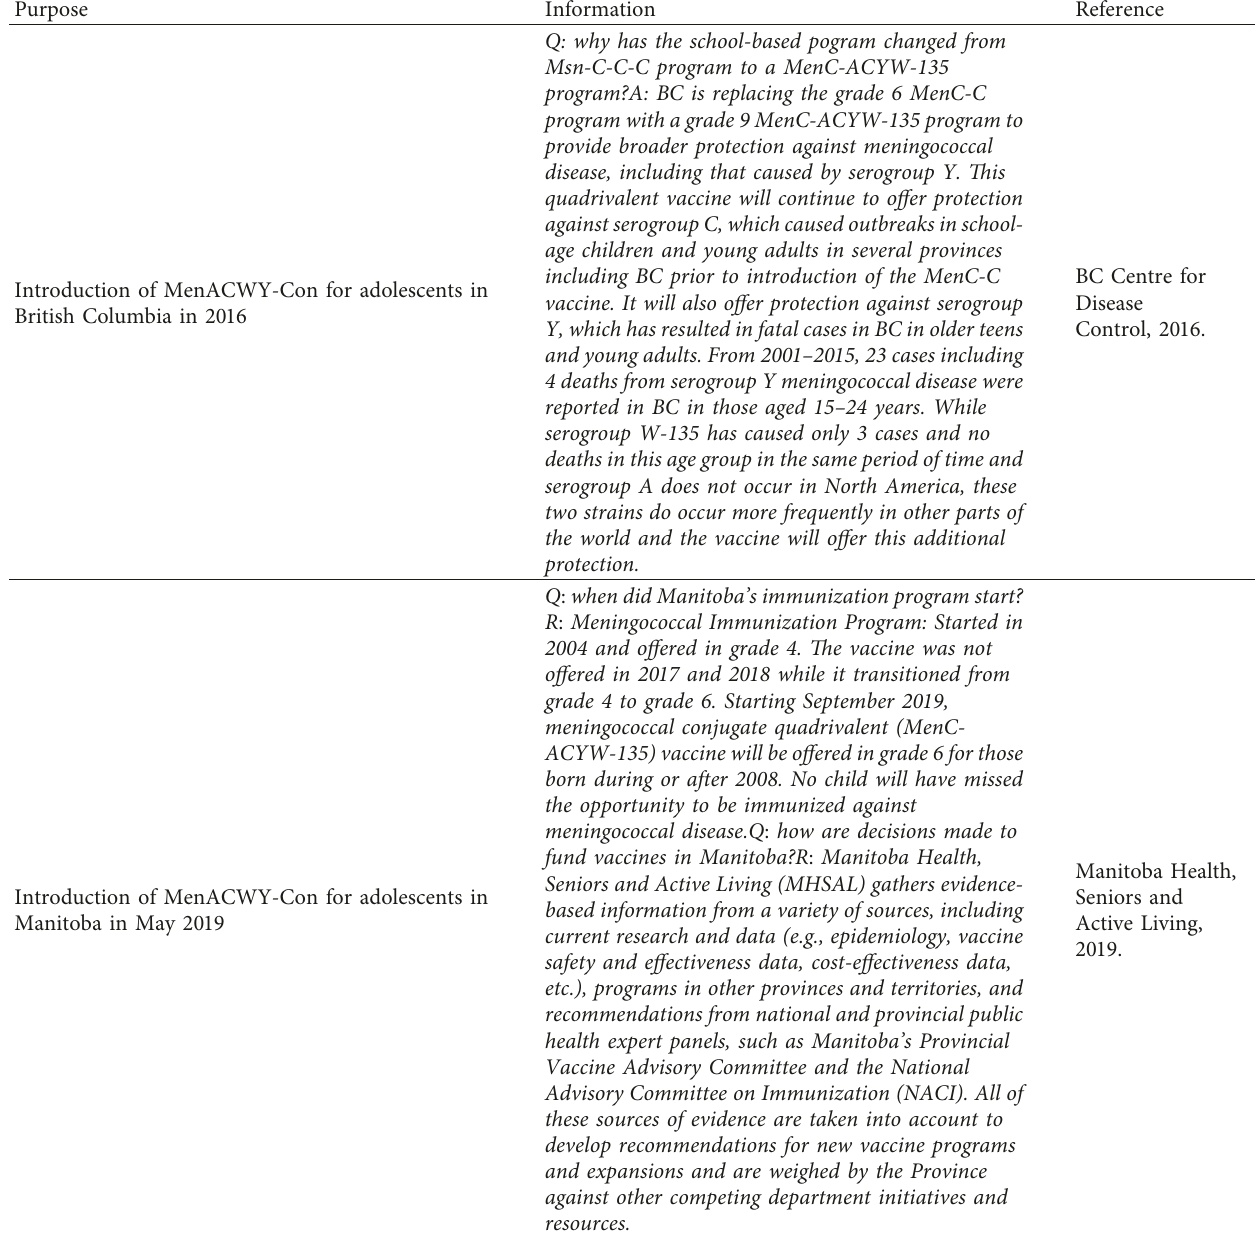
Table 3: Examples of information issued by provincial health authorities in Canada regarding changes in immunization